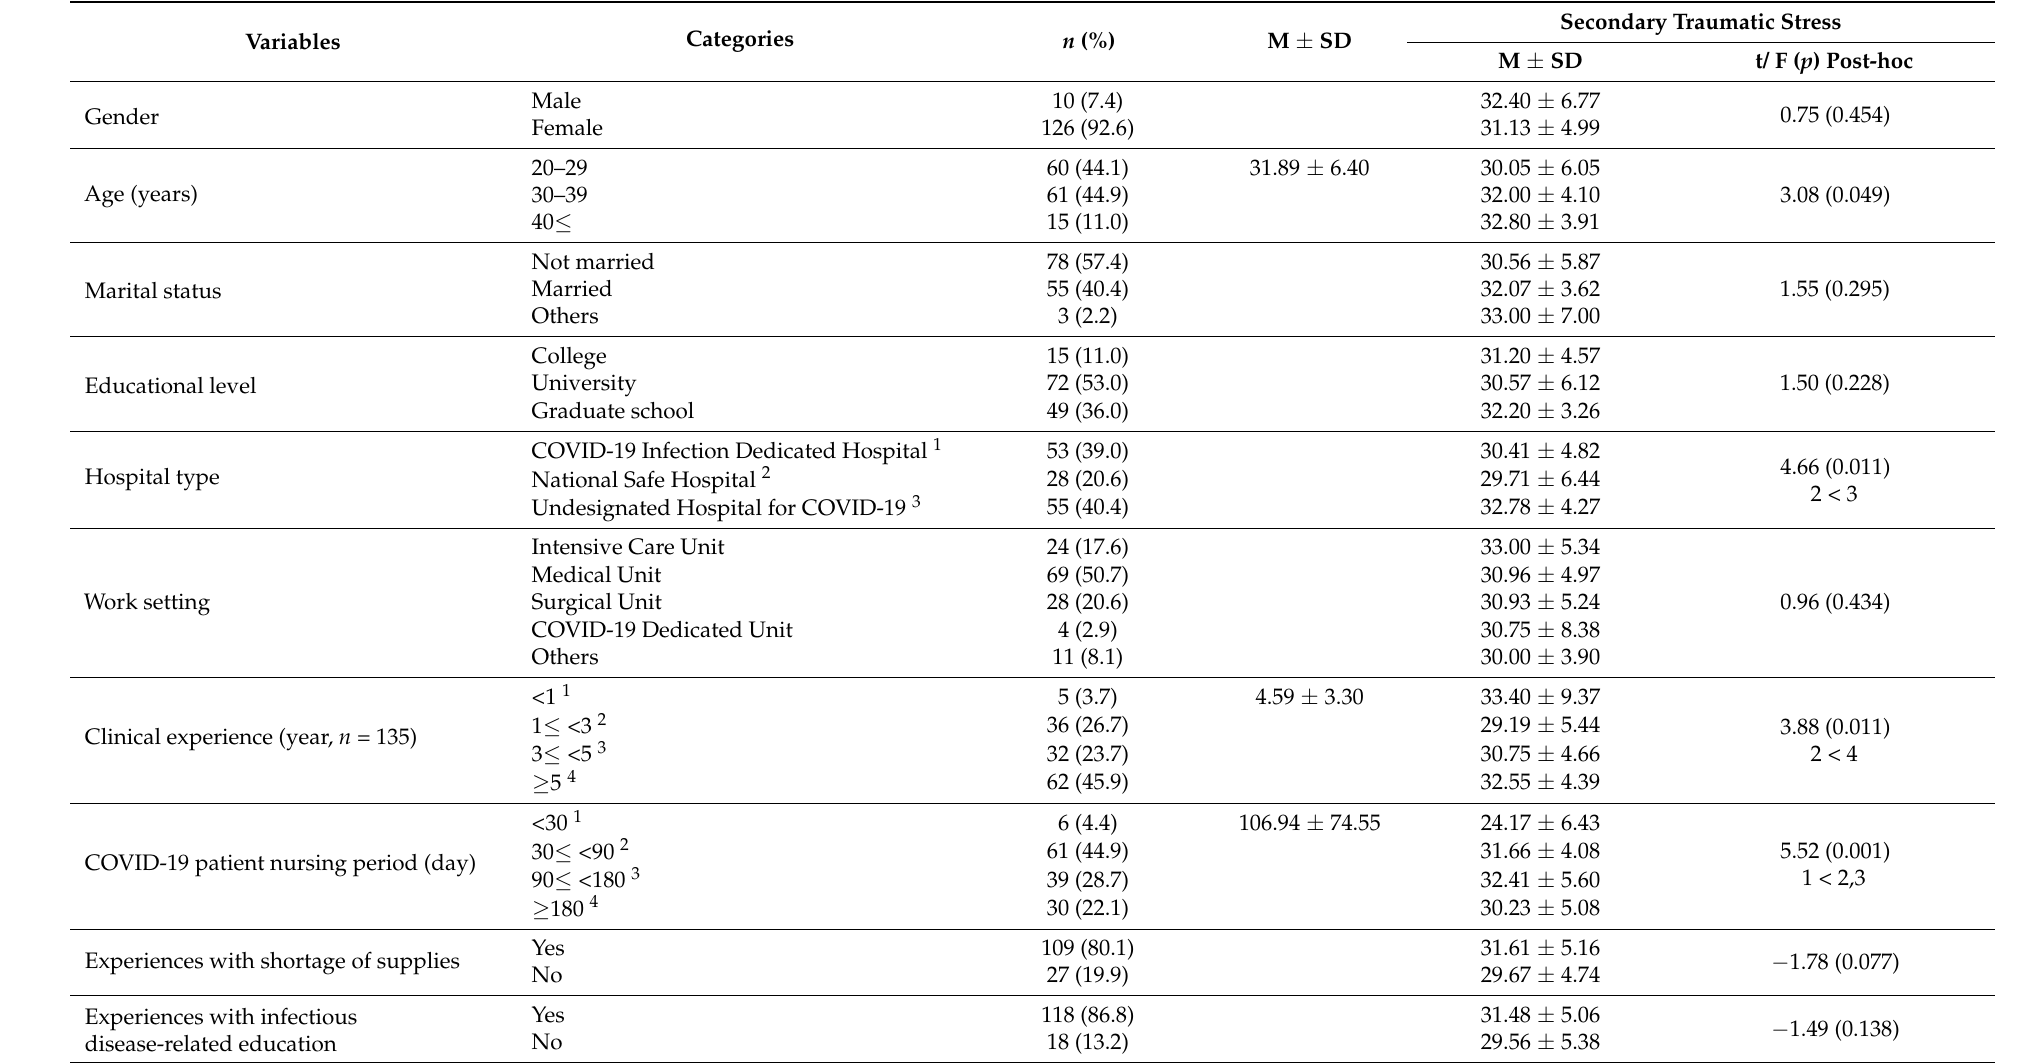
Table 1. Differences in secondary traumatic stress by general characteristics (N =